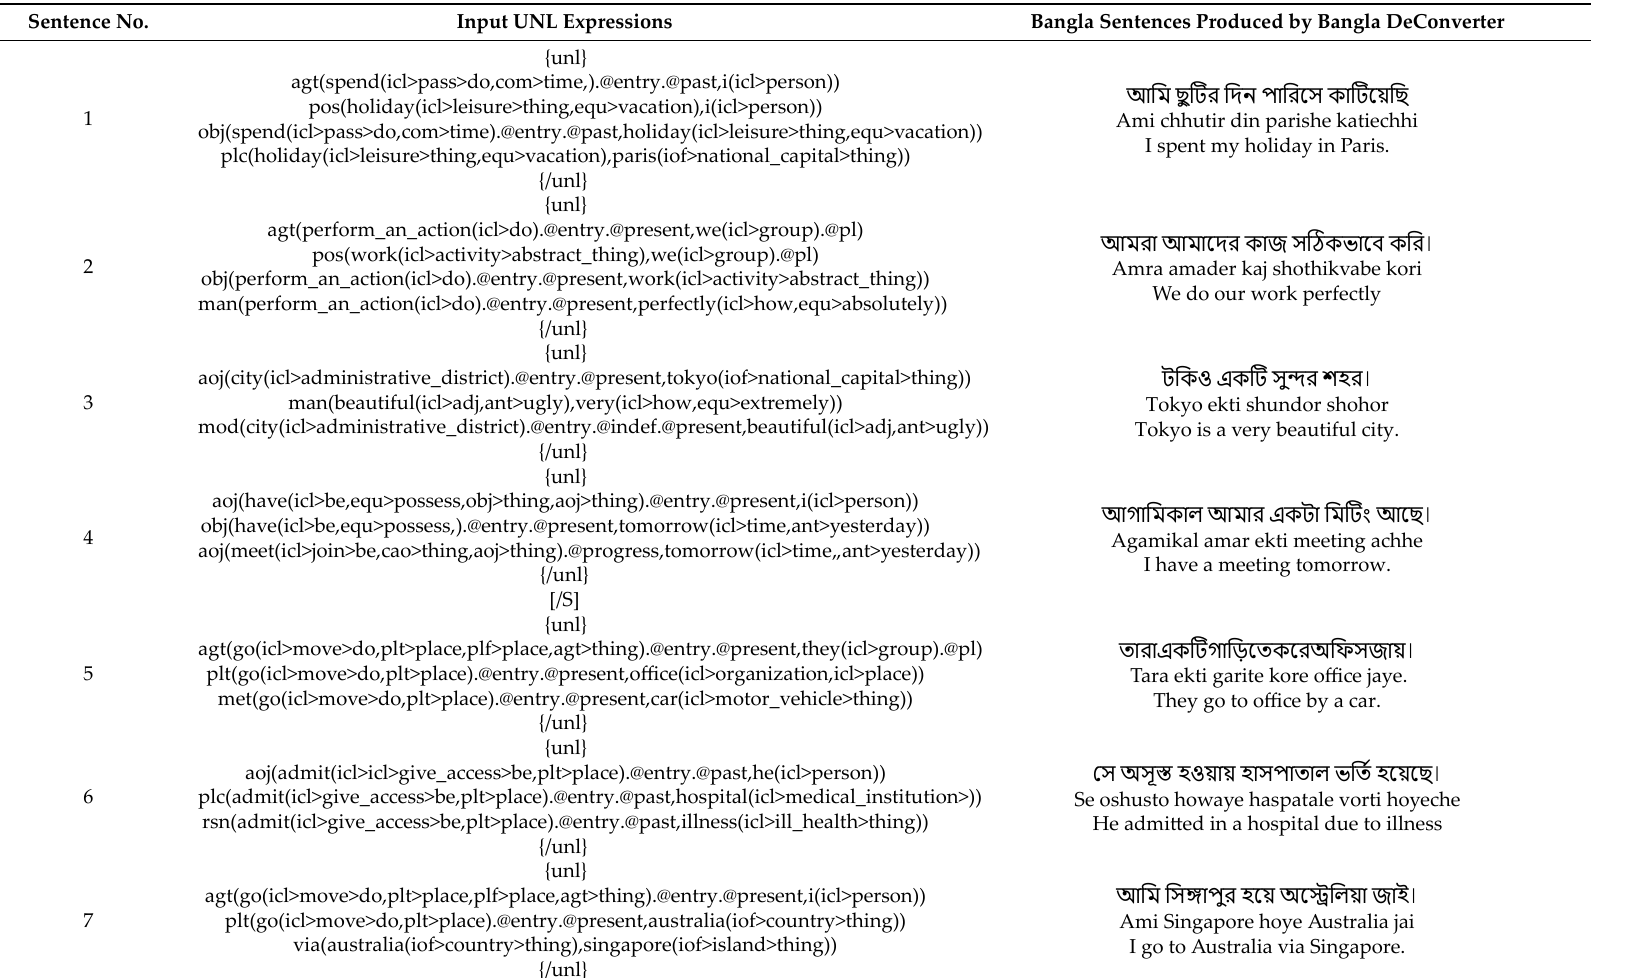
Table 3. Bangla sentences produced by the proposed Bangla DeCo with their corresponding input UNL expressions. Sentence